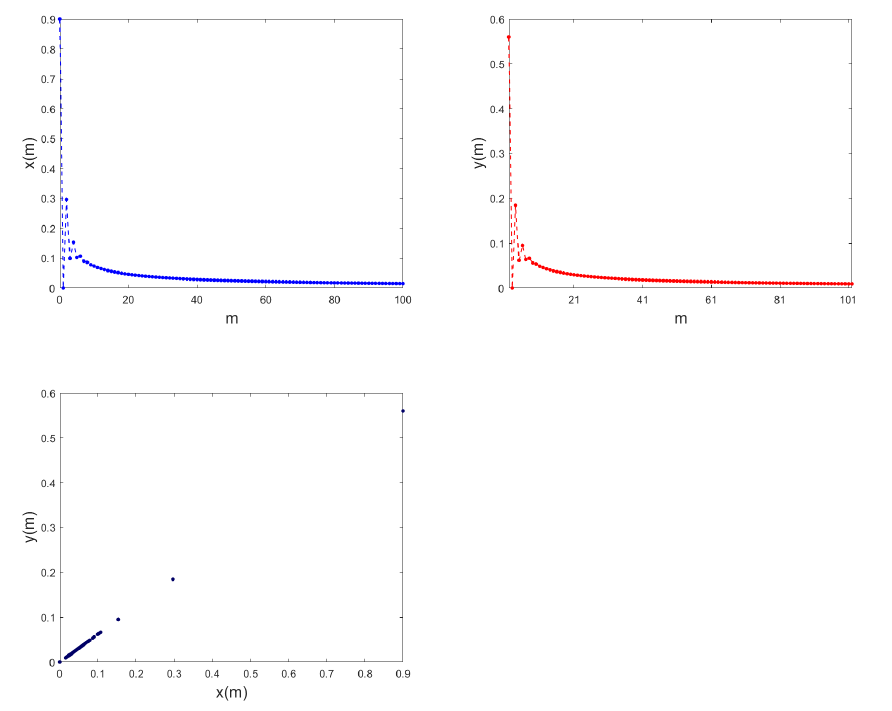
Figure 10. Time evolution of the controller fractional predator–prey discrete system of Leslie type (17) for γ = 0.67, a = 2.2, b = 5, c = 5.5, δ = 1.05 and ( x ( 0 ) , y ( 0 )) = ( 0.9,0.56 )